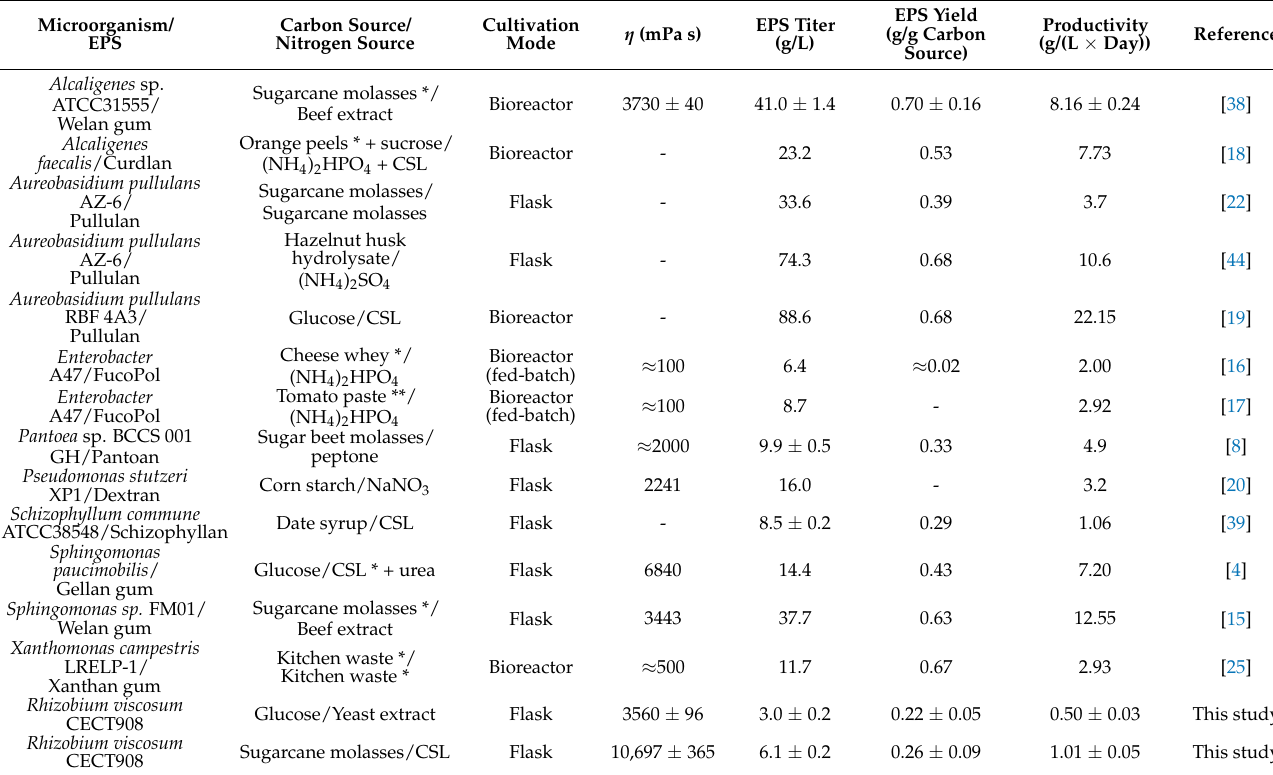
Table 1. Summary of the results obtained for the production of different extracellular polysaccharides (EPS) using different by-products and